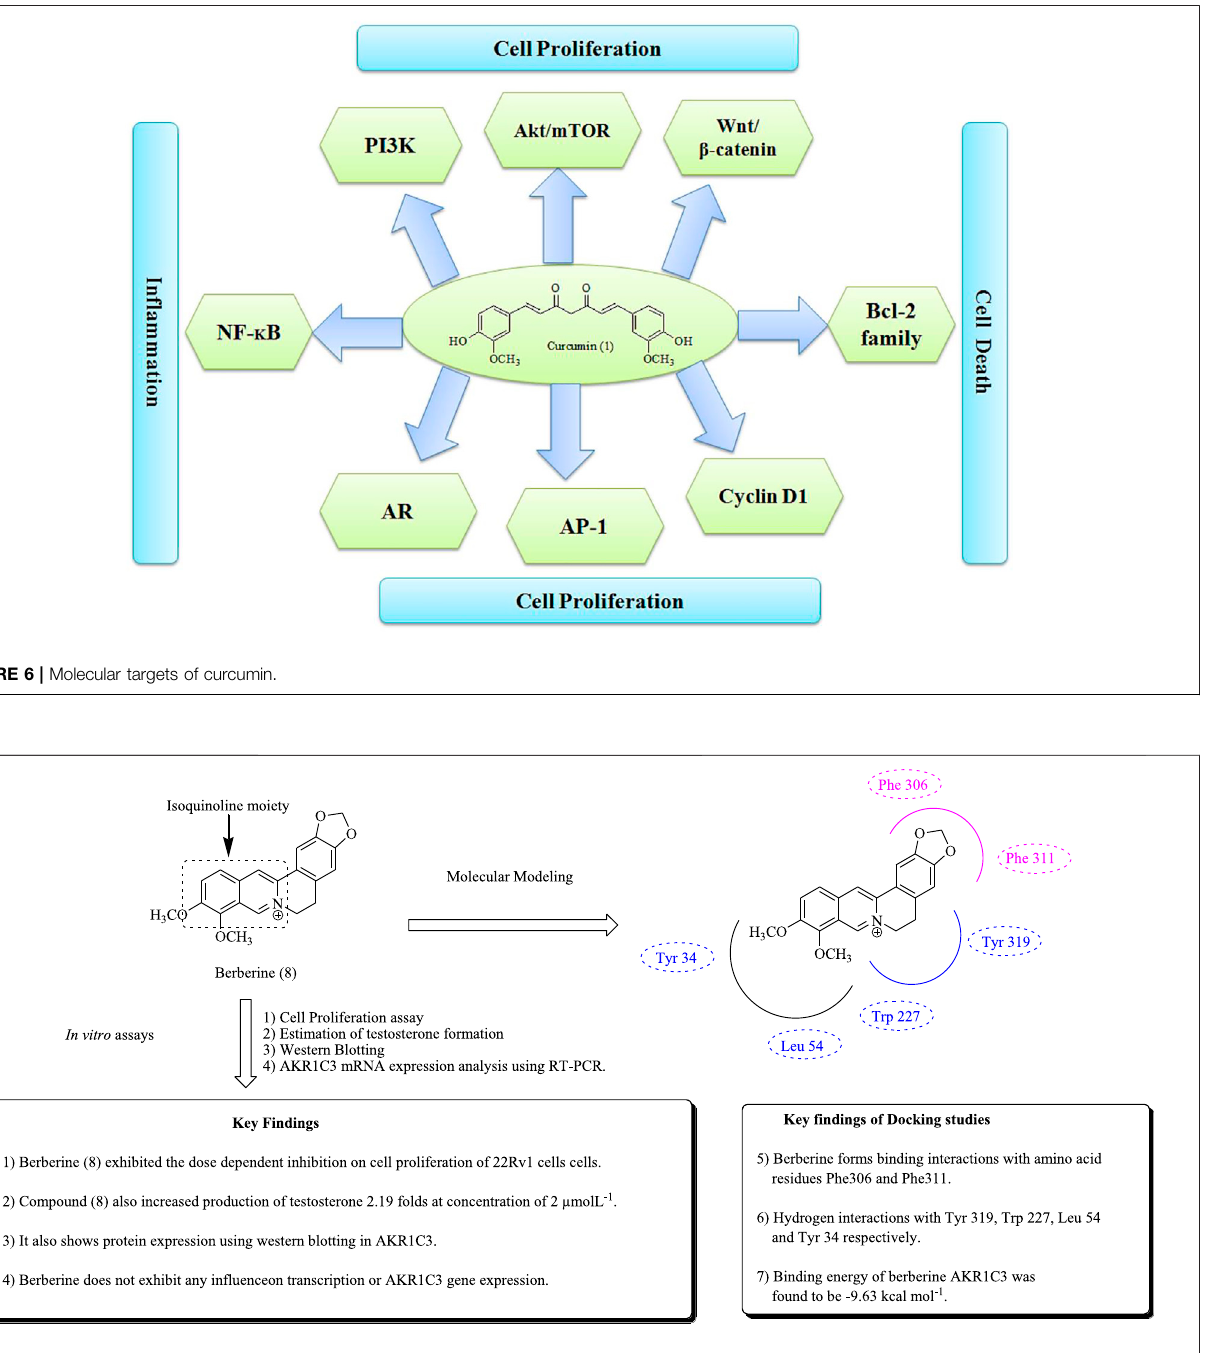
Frontiers in Pharmacology |